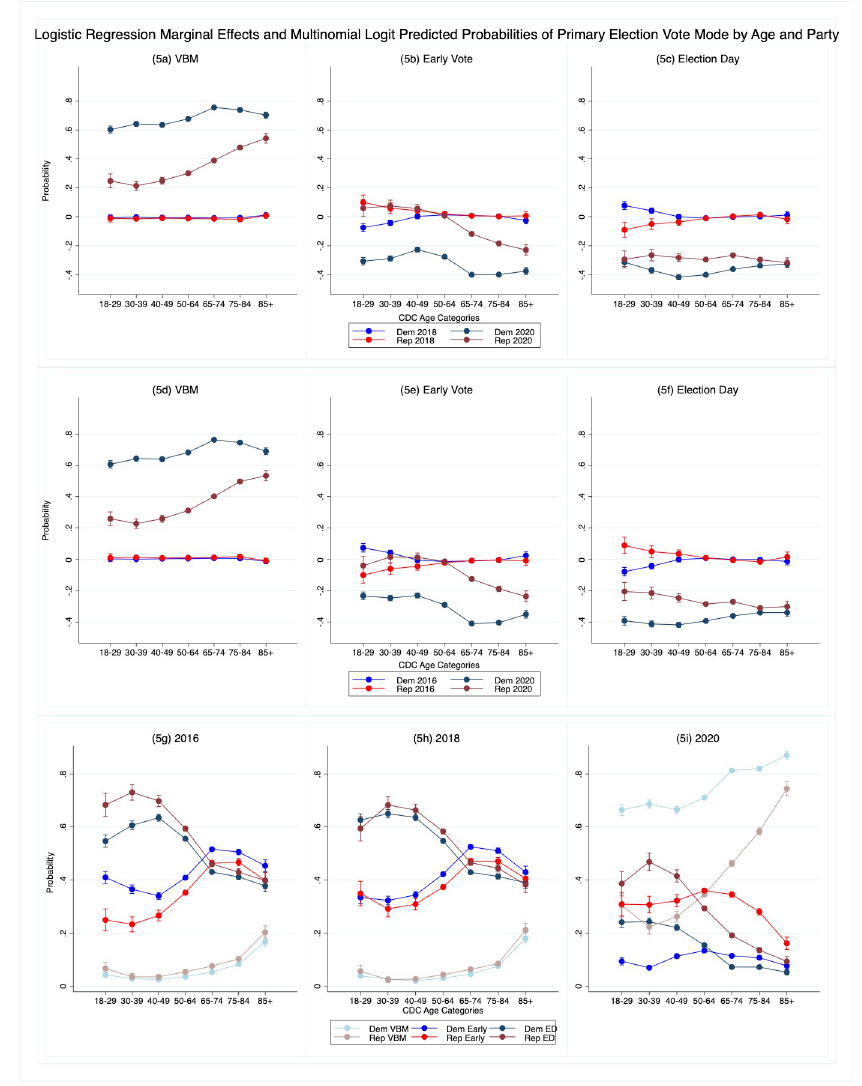
Fig 5. a–i. Logistic regression marginal effects and multinomial logit predicted probabilities of primary election vote mode by age and